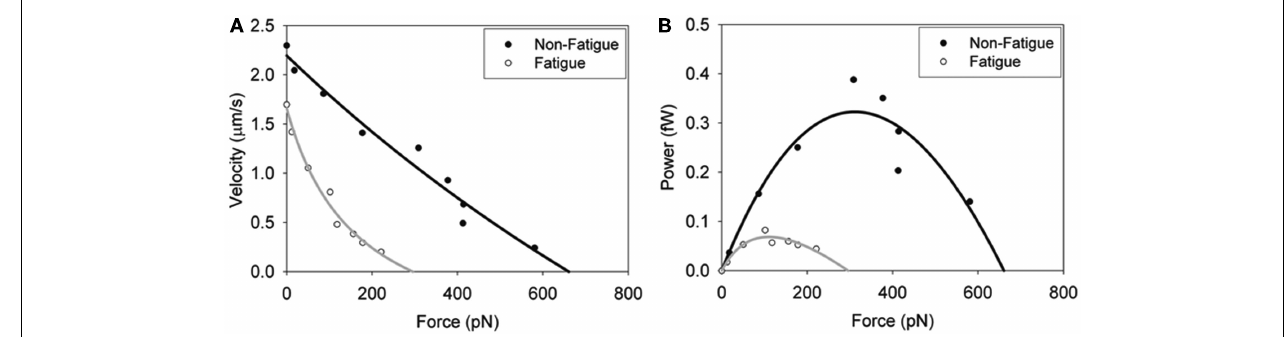
equation (Hill, 1938) with the black line normal conditions and the gray line fatigue-like conditions.The force–power relationships (B) were derived by calculating the product of force and velocity and fit to the Hill force–power equation (Hill, 1938). Figure reprinted from Greenberg and Moore (2010) with permission from JohnWiley and